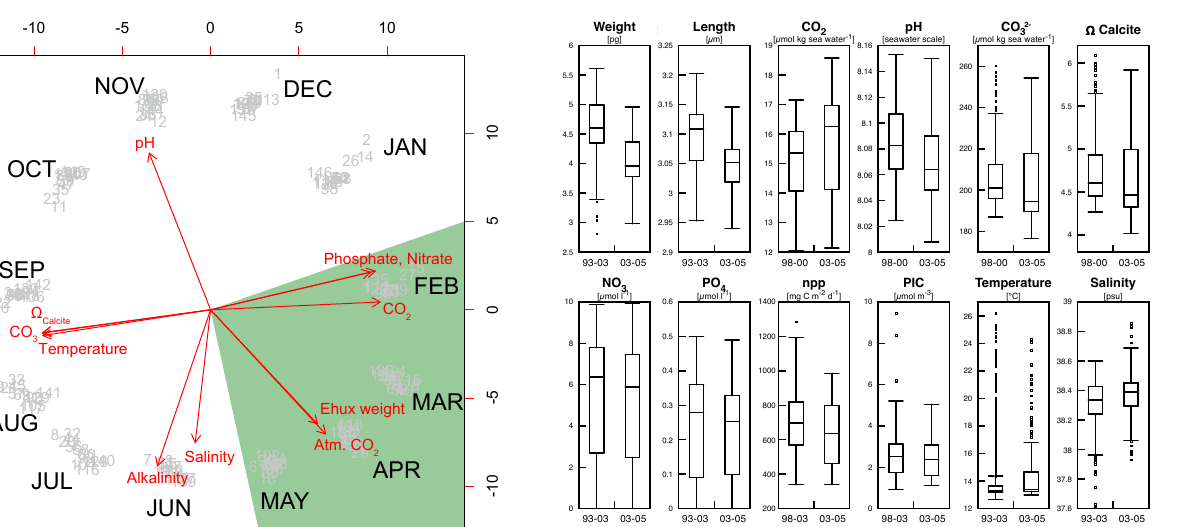
Figure 7. Comparison of data from time periods before August 2003 with August 2003 to December 2005. Environmental data shown in Fig. 4 have been used in the box and whisker plots show- ing the quartiles of the data, with the median represented by the horizontal lines inside the boxes. Open circles indicate ] 3